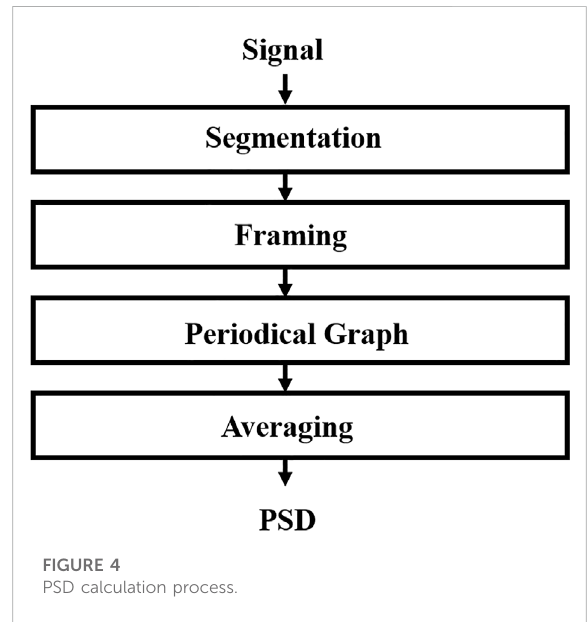
FIGURE 4 PSD calculation